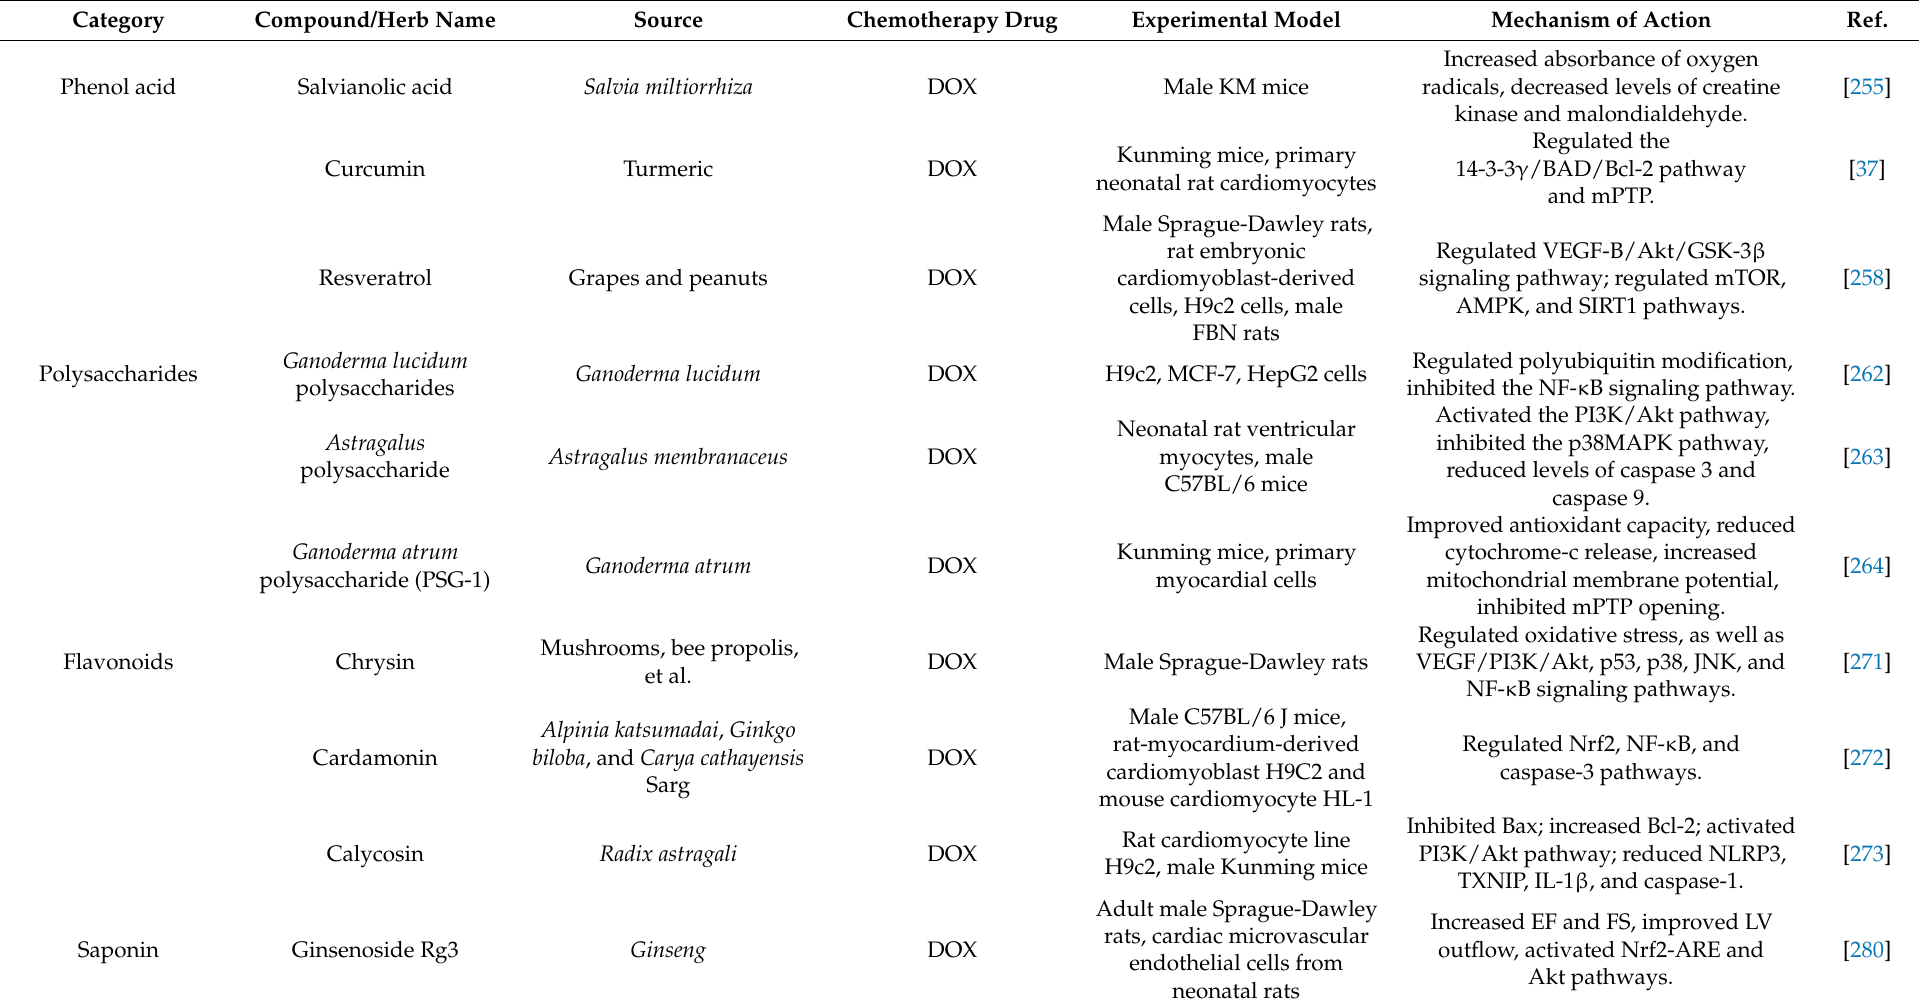
Table 1. Representative drugs to reduce cardiac toxicity caused by tumor treatment in published